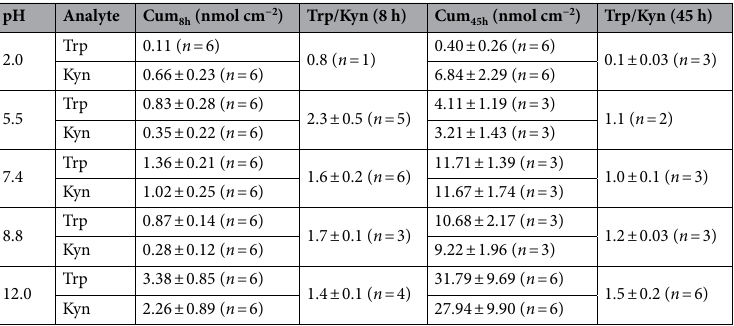
The cumulative amount of permeated Trp is higher as compared to corresponding value of Kyn at all inves- tigated pH values, except for pH 2.0. An obvious outcome of this finding is that the sampled Trp/Kyn ratio, presented in Fig. 2B, is higher than unity for all pH values, except for pH 2. However, the Trp/Kyn ratio changes